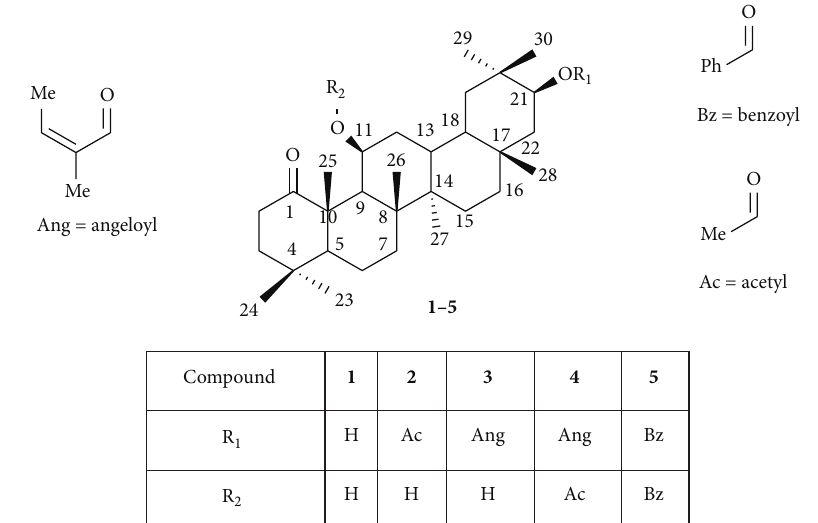
Figure 1: Presentation of compounds 1 – 5 .